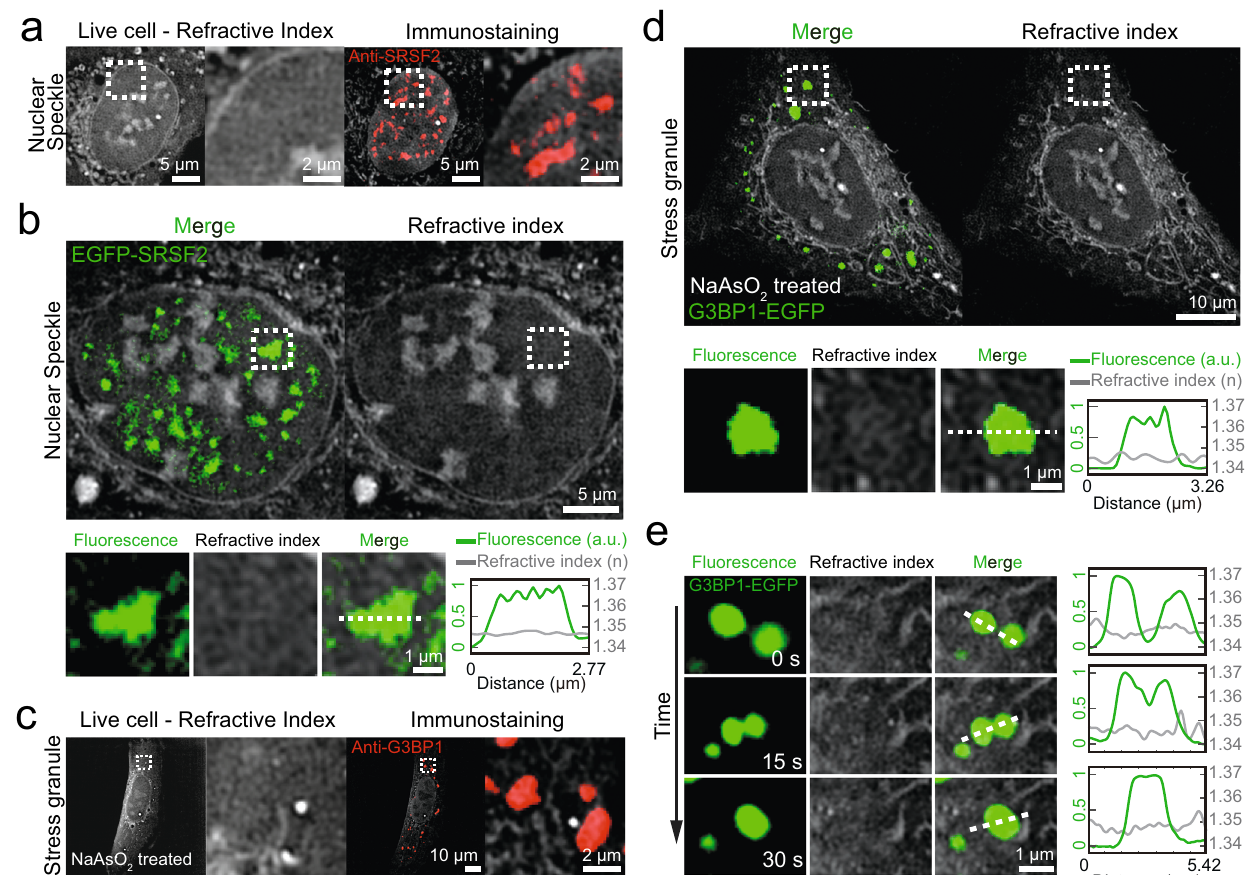
Fig. 2 | Nuclear speckles and stress granules are low-density condensates. a (Left) RI images of an intact live U2OS cell. (Right) Combined RI and immuno- fl uorescence images of the same cell after fi xation. Anti-SRSF2 is used to target nuclearspeckles. b (Top) Combined RIand fl uorescence images of a live U2OScell expressing EGFP-SRSF2. (Bottom left) Zoomed-in images of a single nuclear speckle. (Bottom right) Intensity pro fi le plot for normalized fl uorescence inten- sities of EGFP-SRSF2 (green line) and RIs (gray line) along the white dashed line. c (Left) RI images of a live U2OS cell treated with 500 μ M sodium arsenite. (Right) Combined RI and immuno fl uorescenceimages ofthe same cellafter fi xation. Anti-